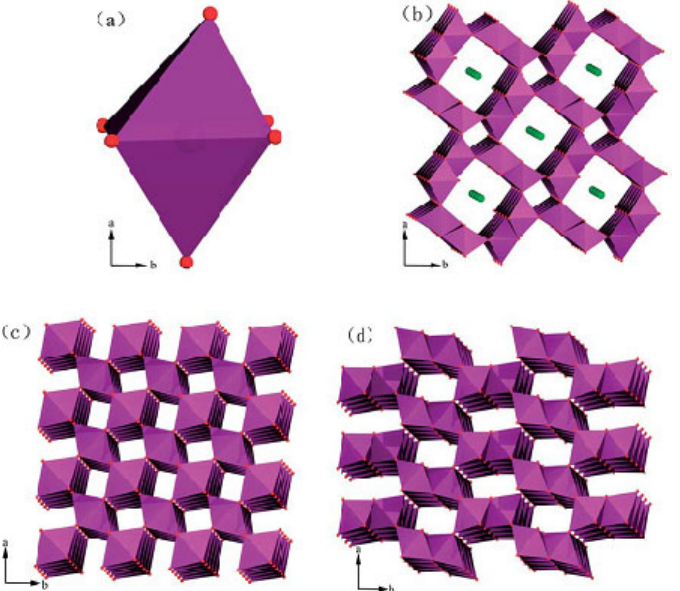
Figure 11. Polyhedral representations of the crystal structures of varieties of MnO 2 : ( a ) [MnO 6 ] octahedron, ( b ) cryptomelane-type α -MnO 2 , ( c ) pyrolusite-type β -MnO 2 , and ( d ) nsutite-type γ -MnO 2 . Reprinted and adapted with permission from Ref. [87]. Copyright 2014 Royal Society of Chemistry.